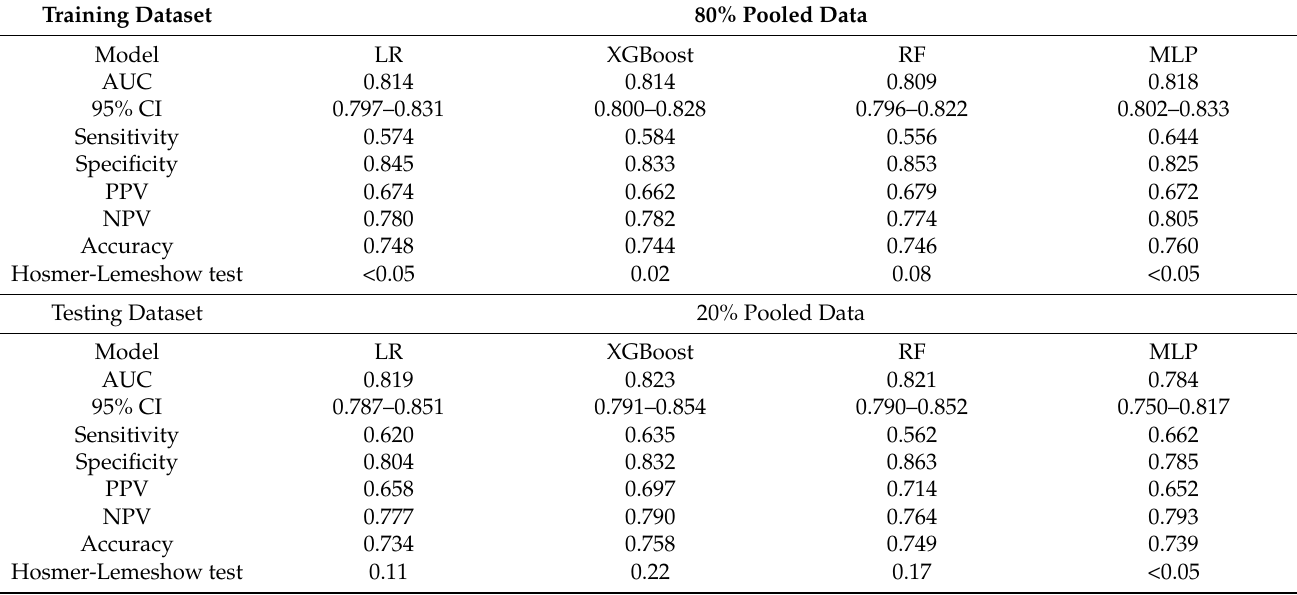
Figure 4. Area under operating characteristic (ROC) curves for prediction models trained in 80% pooled data ( a ) and tested in 20% pooled data ( b ). Red, RF (0.809, 0.821); Green, XGBoost (0.814,